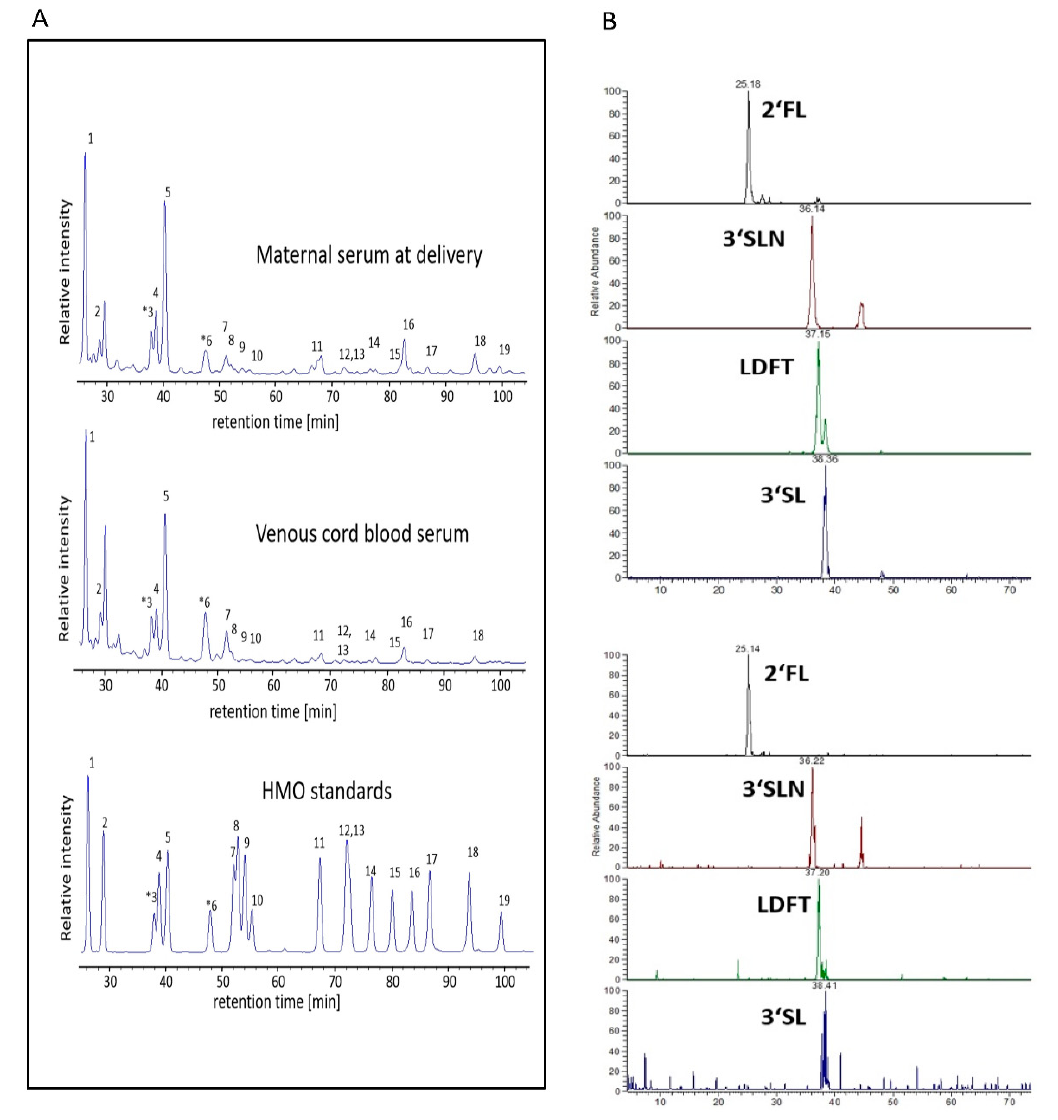
Figure 1. Human milk oligosaccharides (HMOs) are present in cord blood and resemble HMO profiles in maternal serum at delivery. ( A ) Representative HPLC chromatograms of oligosaccharides in pregnant serum at delivery (first panel) and in venous cord blood serum (second panel). As control, a mixture of commercially available human milk oligosaccharide standards (third panel) is shown. ( B ) Mass chromatograms of oligosaccharides isolated from pooled maternal peripartal samples (upper panel) and from pooled cord blood samples (lower panel), acquired by LC-MS/MS in multiple reaction monitoring (MRM) mode. Panels show the mass transitions 609/301 for 2 ′ FL and 3FL, 754/301 for 3 ′ SL, 755/301 for LDFT, 795/325 for 3SLN. (1) 2 ′ -Fucosyllactose (2 ′ FL), (2) 3-fucosyllactose (3FL), (3) 3 ′ -siallyllactosamine (3 ′ SLN), (4) lactodifucotetraose (LDFT), (5) 3 ′ -sialyllactose (3 ′ SL), (6) 6 ′ -sialyllactosamine (6 ′ SLN), (7) 6 ′ -sialyllactose (6 ′ SL), (8) lacto- N -tetraose (LNT), (9) lacto- N -neotetraose (LNnT), (10) 3 ′ -sialyl-3-fucosyllactose (3 ′ S-3FL), (11) lacto- N -fucopentaose 1 (LNFP1), (12,13) lacto- N -fucopentaose 2/3 (LNFP2/3), (14) sialyllacto- N -tetraose a (LSTa), (15) sialyllacto- N -tetraose b (LSTb), (16) sialyllacto- N -tetraose c (LSTc), (17) lacto- N -difucohexaose (LNDFH), (18) lacto- N -hexaose (LNH), (19) disialyllacto- N -tetraose (DSLNT).